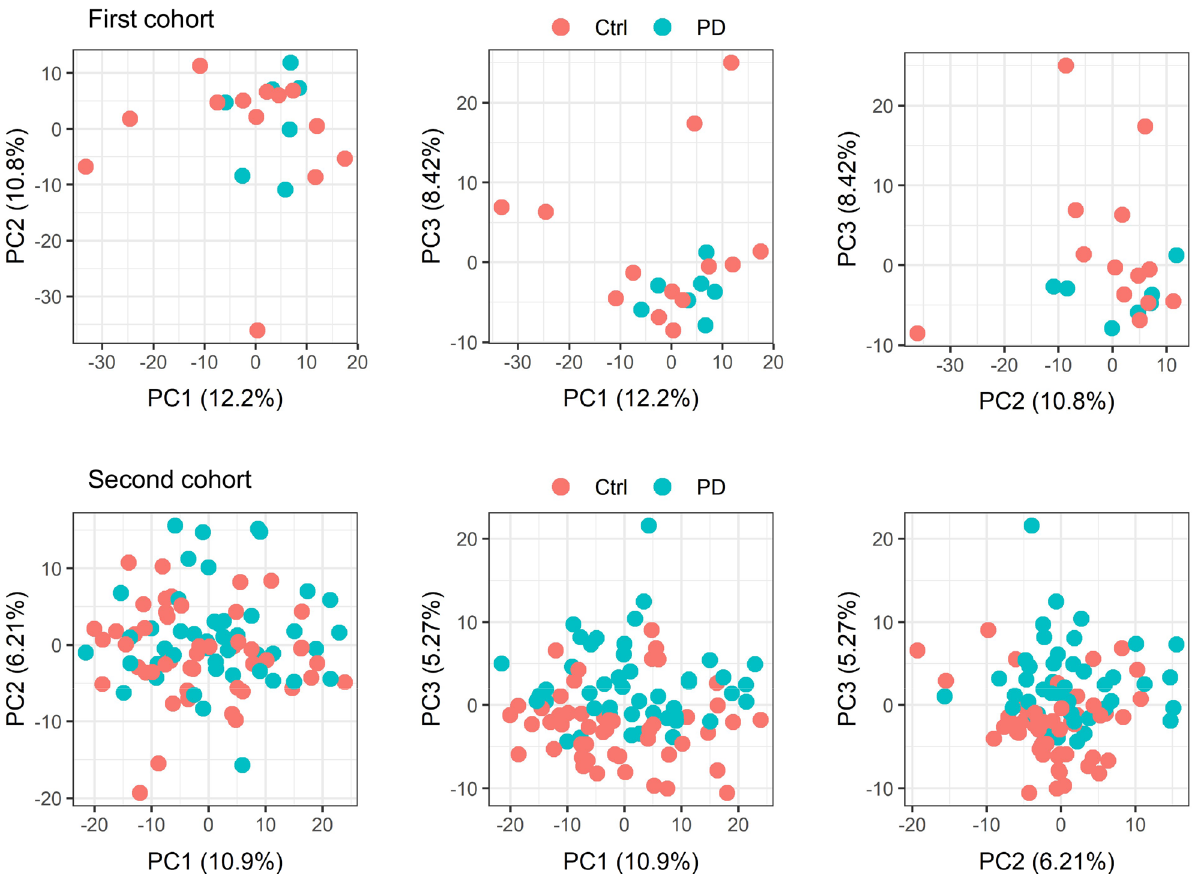
Figure 1. Principal component analysis using SSL-RNA profiles. The panels show two-dimensional principal component analysis plots with PC1–PC2, PC1–PC3, and PC2–PC3, respectively. Ctrl healthy controls, PD Parkinson’s disease, PC principal component. The plots were constructed using ggplot2 R package 19